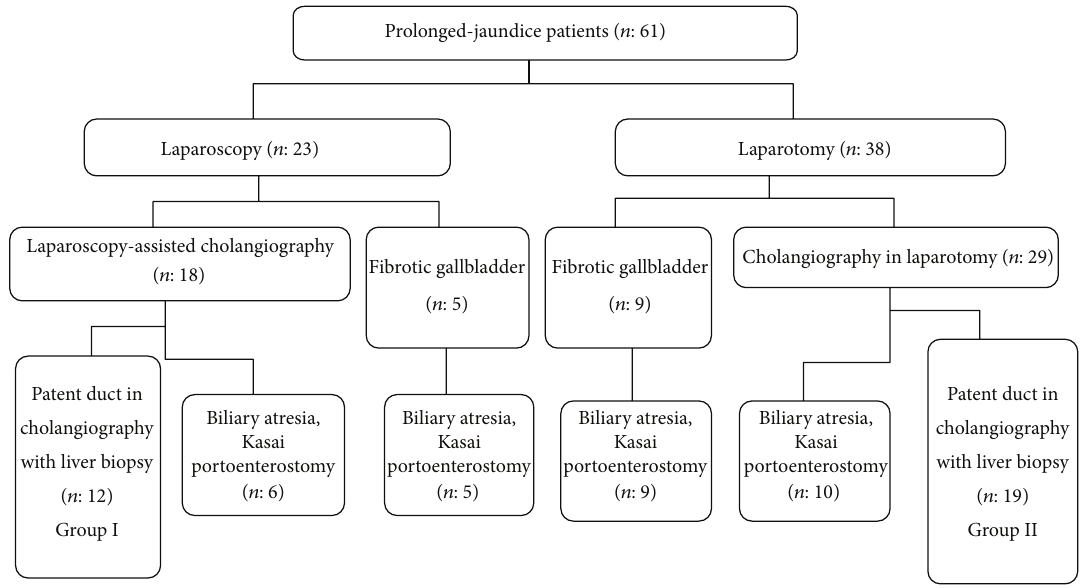
Figure 5: Data flow chart of the referred prolonged-jaundice